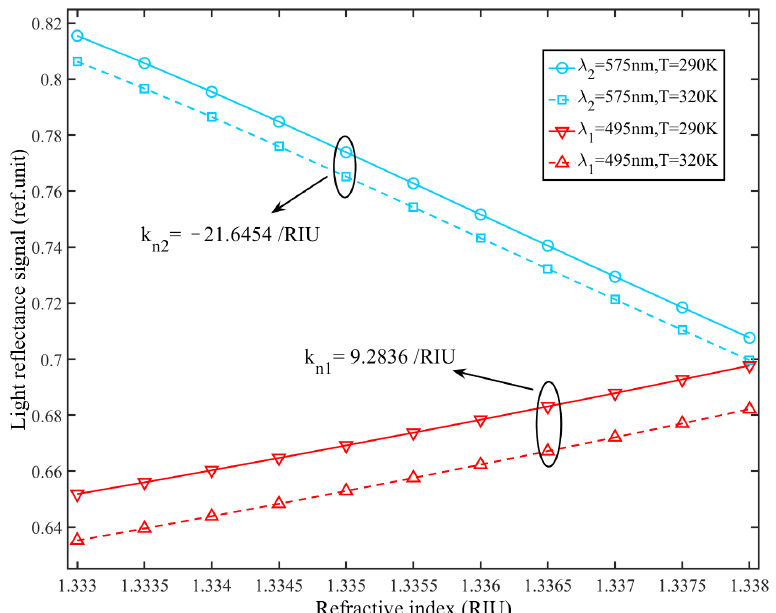
Figure 6. SPR reflected signal shifts versus RI for the temperature at 290 K and 320 K.